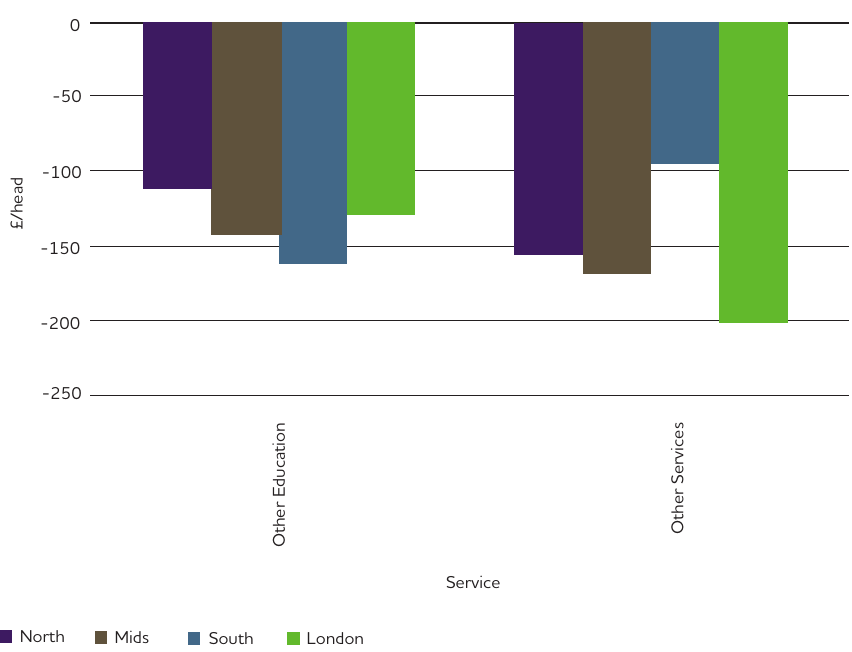
Figure 4: Real Budget Changes by Other Education vs Other Services for English All Purpose Authorities by Broad Region, £ per head,